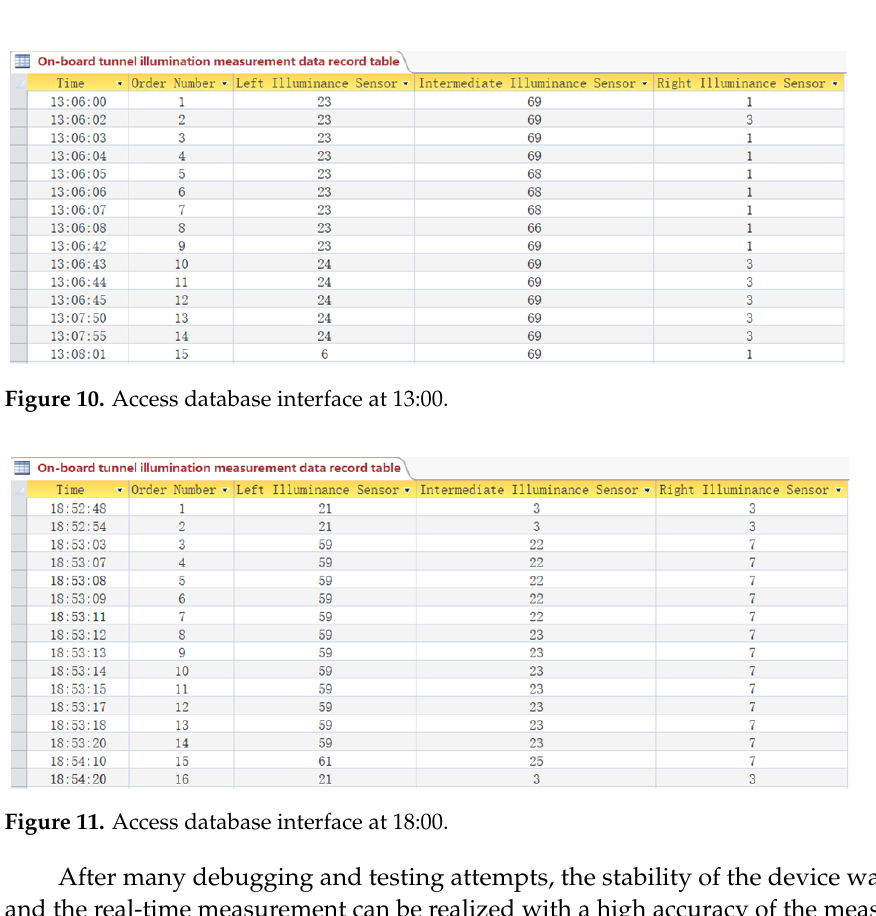
Figure 12. Hardware equipment of vehicle-mounted tunnel illumination detection device.